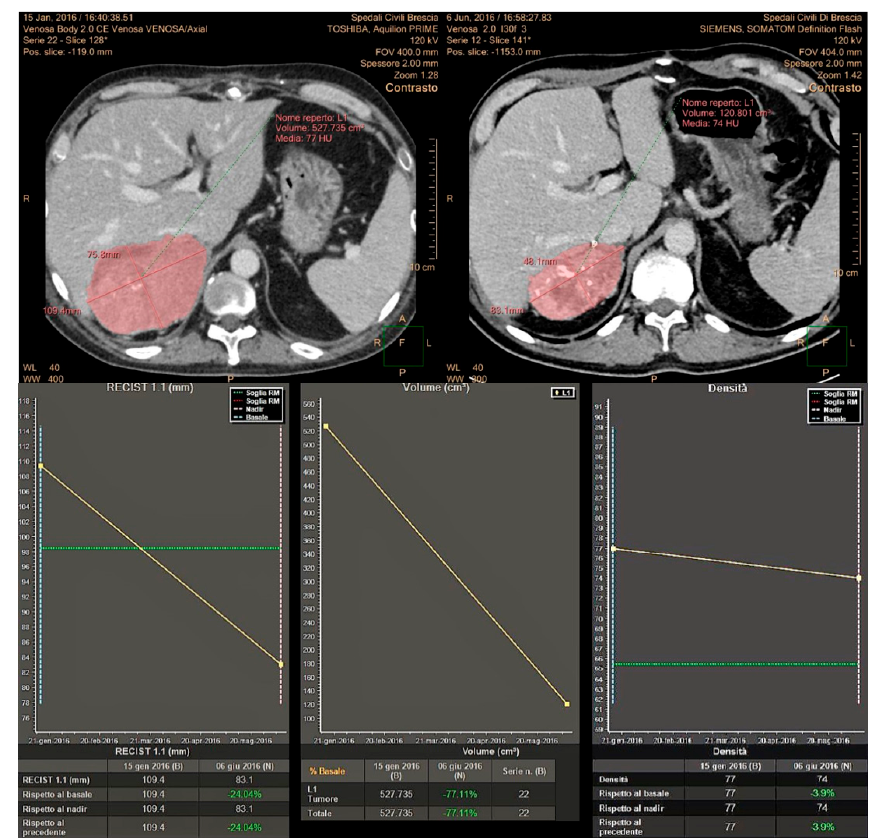
Figure 6. Concordance of the three response criteria in the assessment of a primary metastatic ACC, with planar dimensions changes (RECIST 1.1), tumor volume and tumor size / attenuation (according to